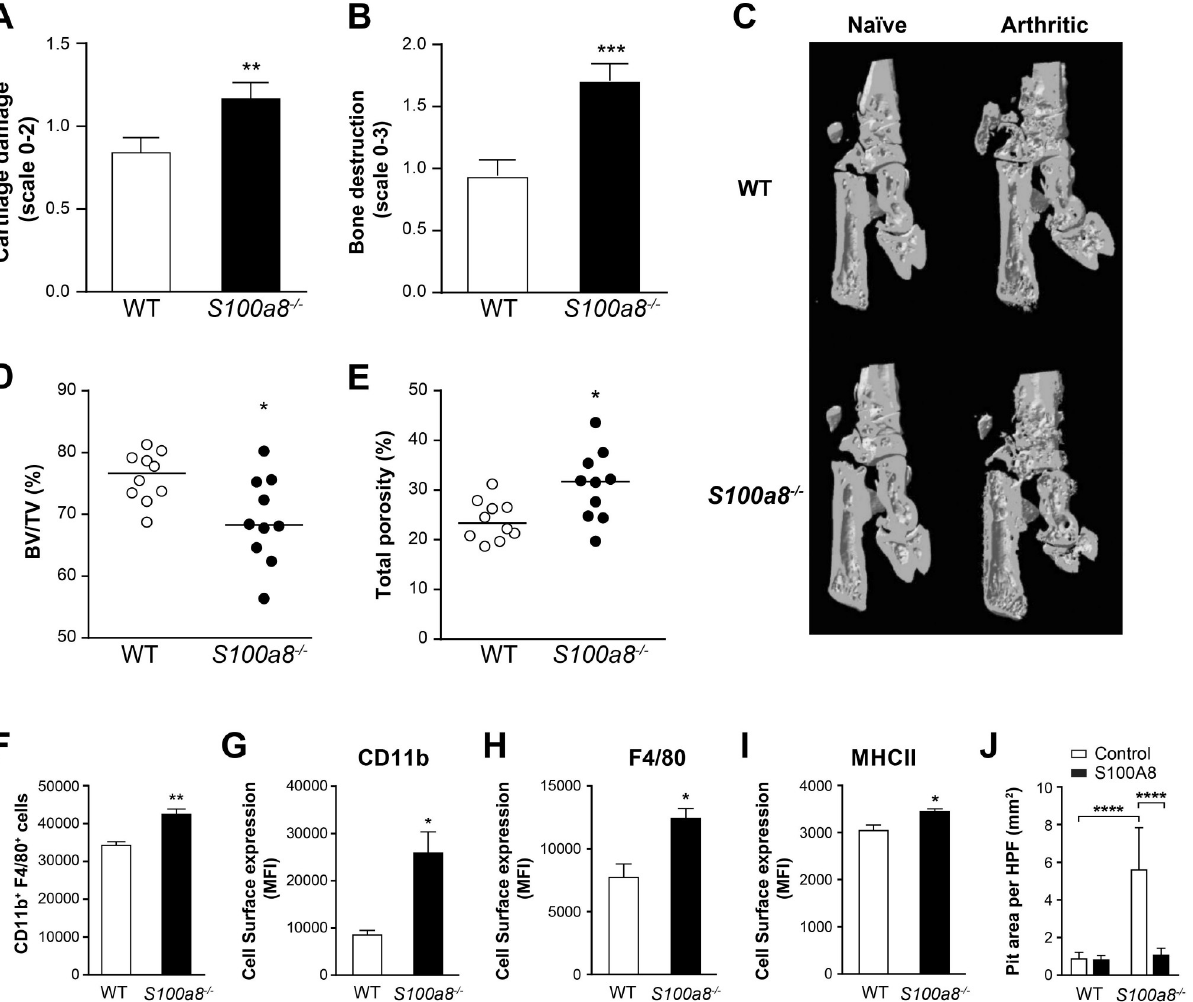
Fig 5. Increased bone destruction and osteoclast activity in S100a8 -/- mice with collagen-induced arthritis. (A) Cartilage degradation in paws, histological scale of 0–2 and (B) bone destruction, histological scale of 0–3, as assessed by two impartial observers (n = 20 for WT and n = 19 for S100a8 -/- mice). (C) 3D surface renderings showing bone erosion as assessed by μ CT scans of paws. One hind paw representative of 9 is shown. (D) Bone volume/tissue volume and (E) total porosity of the astragalus bone of WT and S100a8 -/- arthritic mice. Dots are individual values (bar = mean of 10 measurements). (F) Cultured S100a8 -/- bone marrow cells stimulated with GM-CSF produce more macrophages. The cells were harvested, counted and analyzed by flow cytometry after 6 days. (G–I) Expression of CD11b, F4/80 and MHC class II is increased on the surface of bone marrow-derived macrophages from S100a8 -/- mice compared to WT mice, based on flow cytometry (3 mice, one representative experiment out of 3). (J) Osteoclastic activity of S100a8 -/- bone-marrow-derived cells (obtained by incubation with M-CSF and RANKL for 10 days in osteoassay plates) in the presence of extracellular S100A8. Pit areas were measured by microscopy. Two experiments were performed on cells from different mice. All values are mean ± sem. � p < 0.05; �� p < 0.01; ��� p < 0.001, Student’s t-test.